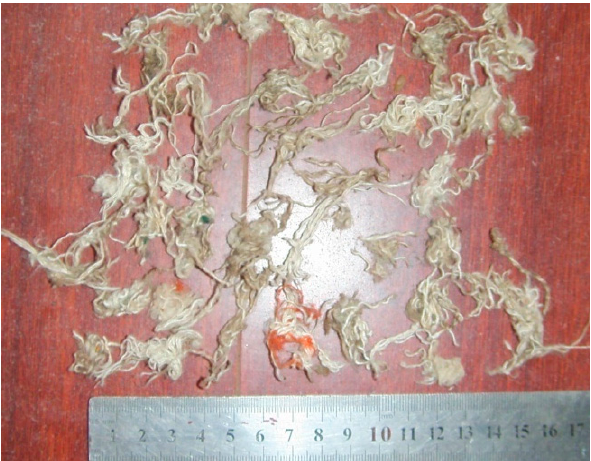
Figure 21. Grinding effect on cotton gloves.